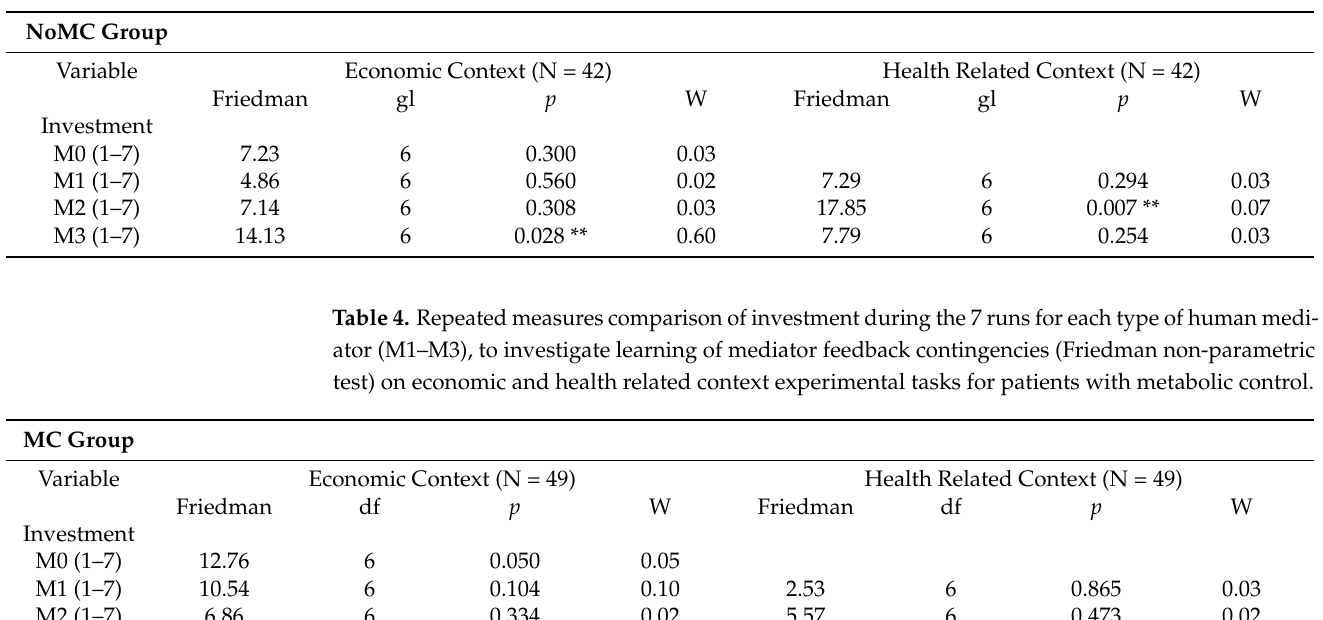
Table 3. A Repeated measures comparison of investment during the 7 runs for each type of human mediator (M1–M3), to investigate learning of mediator feedback contingencies (Friedman non- parametric test) on economic and health related context experimental tasks for patients without metabolic control. ** p value < 0.05.